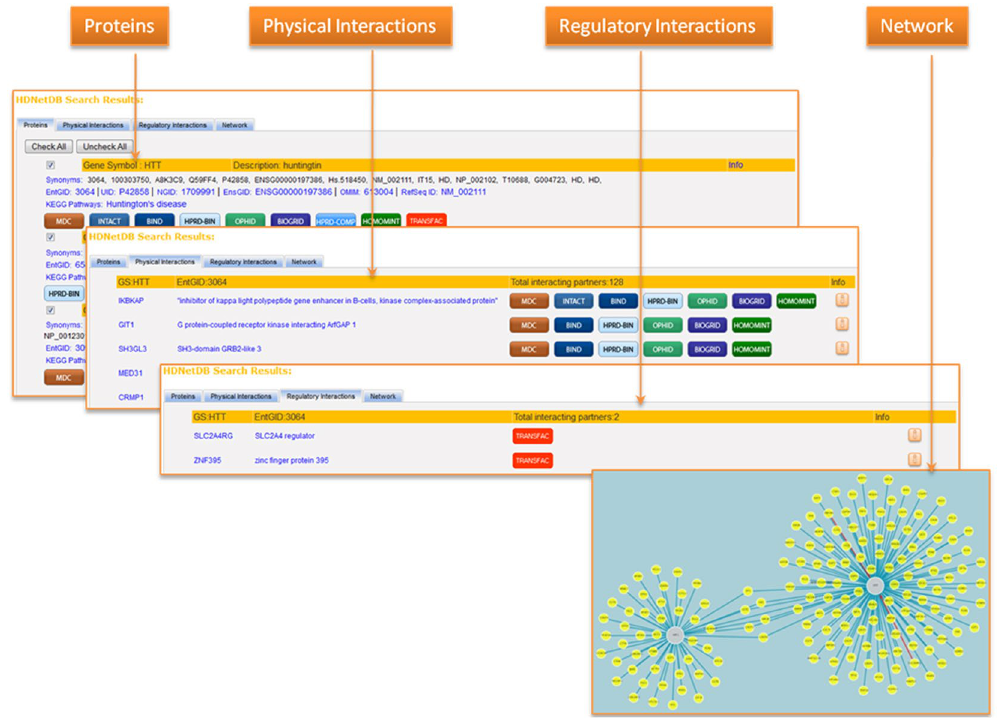
Figure 6. User interface of HDNetDB. After execution of the query, information about proteins and their interactions are shown and visualized on four different pages. The Network page provides additionally various tools for interactive